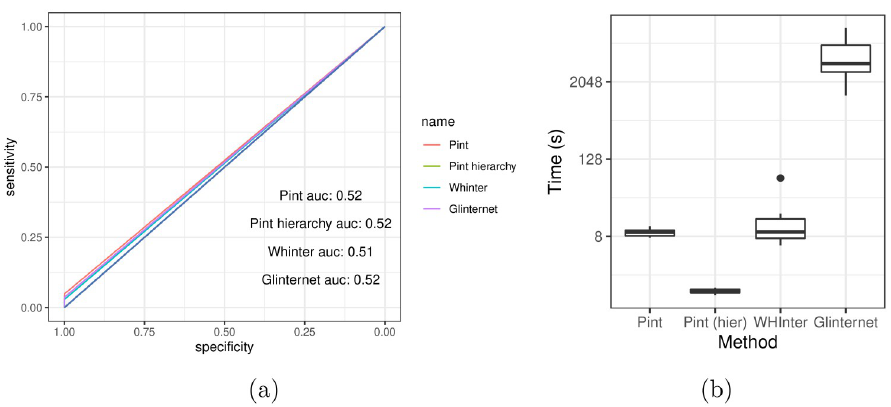
Fig 7. Comparison of methods when 3-way interactions are present. (a) ROC curve for full fit of all 3-way interaction data sets. (b) Time taken for each method. Note that Pint and Pint (hierarchy) are including three-way interactions, whereas glinternet and WHInter include only